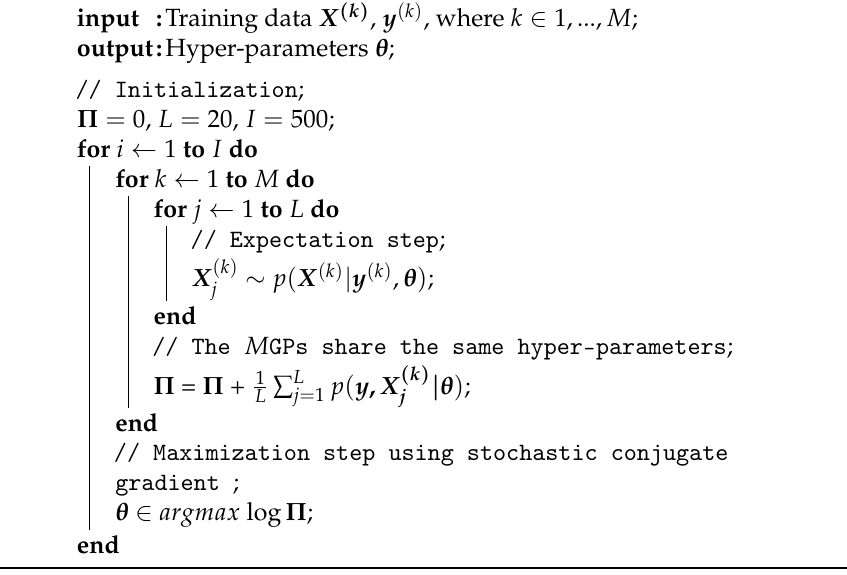
Figure 3. The graphic interpretation of the Monte Carlo sampling. The real distribution in the dashed blue line is not the GP type, but approximated as GP in the solid blue line with the mean and covariance of the corresponding data. Algorithm 1: Calculate hyper-parameter values with Monte Carlo expectation